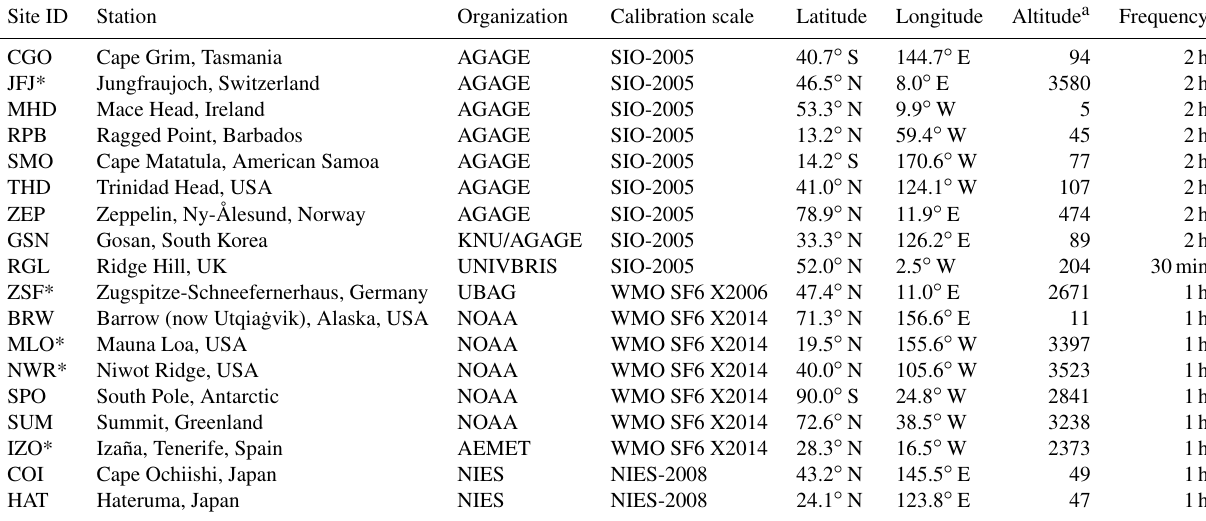
Table 1. Sites of continuous surface measurements used in the inversion and in the reanalysis. Site